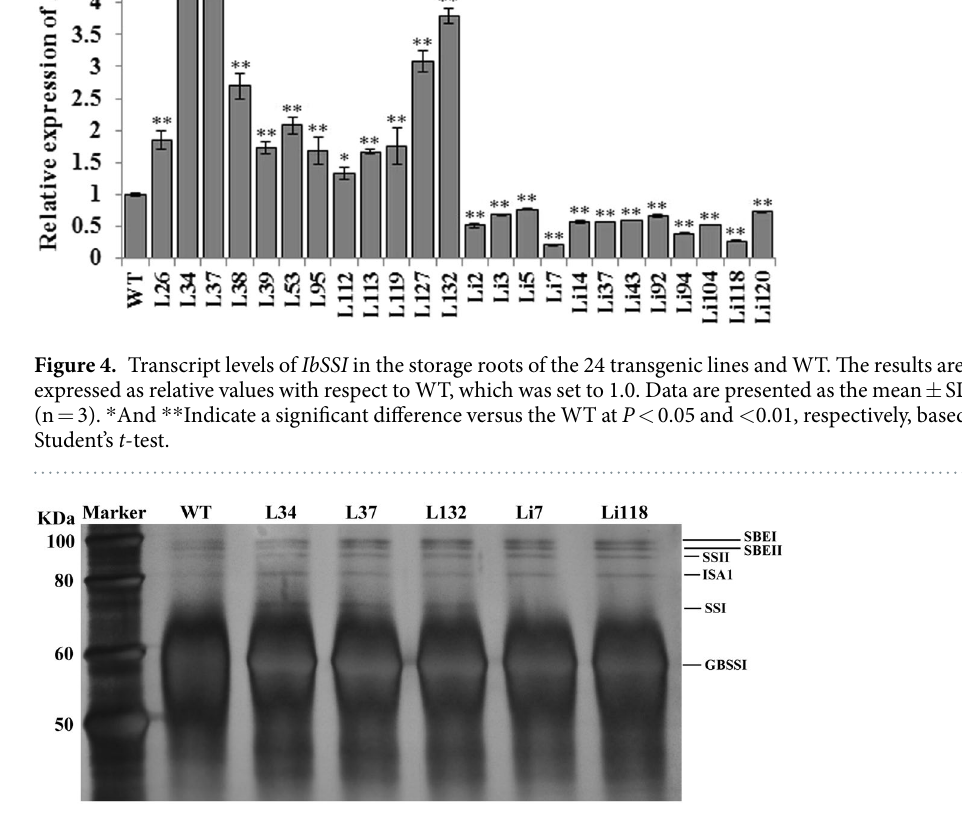
Figure 5. Detection of starch-granule-bound proteins in the transgenic lines and WT. A total of 5 mg of purified starch from each line were boiled in 80 μ L SDS buffer for 5 min and centrifuged at 15,000 g. Equal amount of supernatant (25 μ L) were loaded into the gel. The proteins were visualized by silver staining.